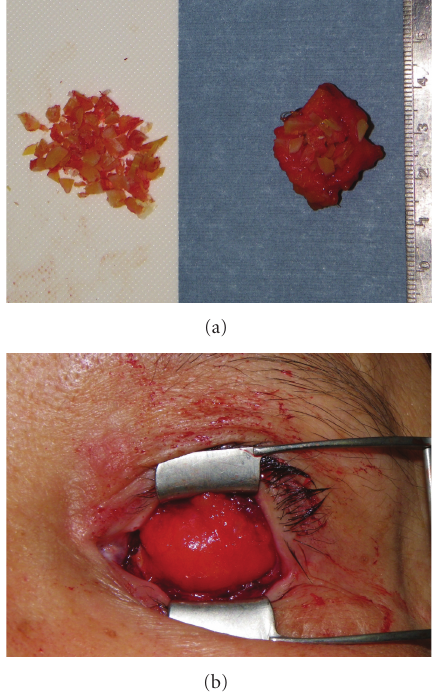
Figure 6: Intraoperative views of the first surgery (Case 2). (a) Diced costal cartilage fragments wrapped with serratus fascia. (b) Prefabricated ball-shaped graft was placed into anophthalmic socket.